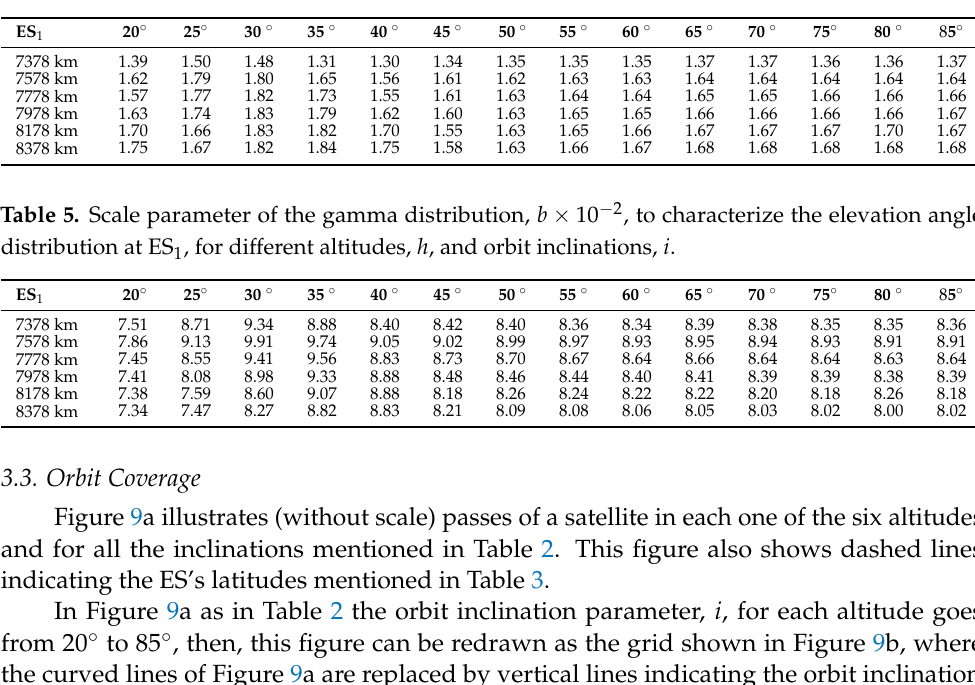
Figure 8. Kolmogorov-Smirnov statistic for the performed simulations at different altitudes. The shape, a , and scale, b , parameters for the gamma distribution were obtained for each of the elevation angle time series of each ES. Those parameters were organized into several matrix arrays as shown in Table 4, which contains the shape parameter for the simulated orbits as seen from the ES 1 , and as in Table 5, which contains the scale parameter also for ES 1 . Table 4. Rate parameter, a , of the gamma distribution to characterize the elevation angle distribution at ES 1 , for different altitudes, h , and orbit inclinations, i .